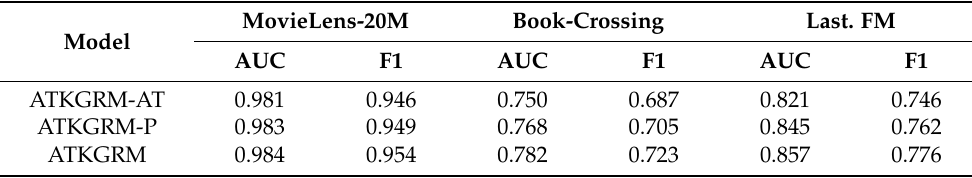
Table 6. Comparison of ablation experimental results of ATKGRM.